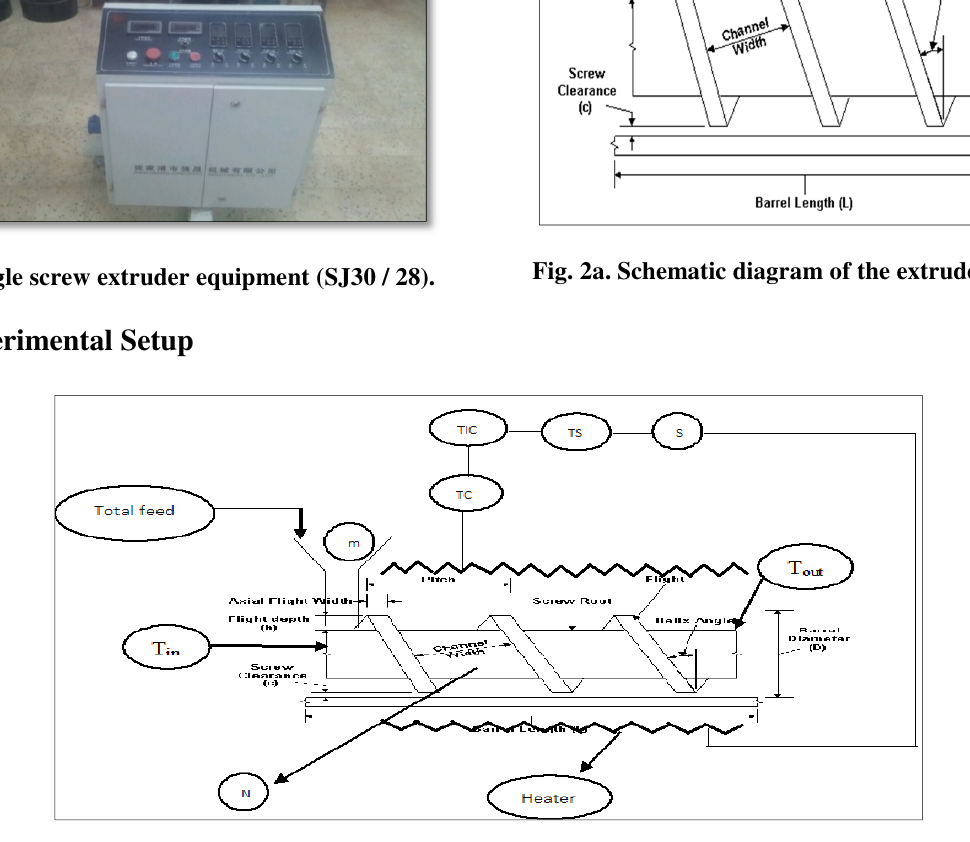
Fig. 2b. Schematic diagram of the extruder with setup